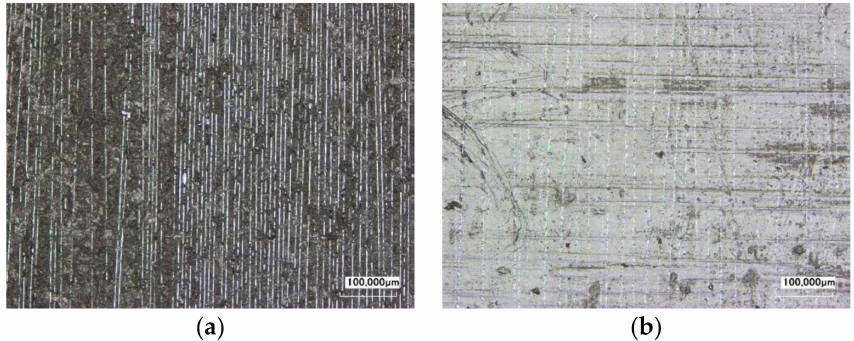
Figure 5. Appearance of the CFRP surface: ( a ) after low pressure blasting and ( b )